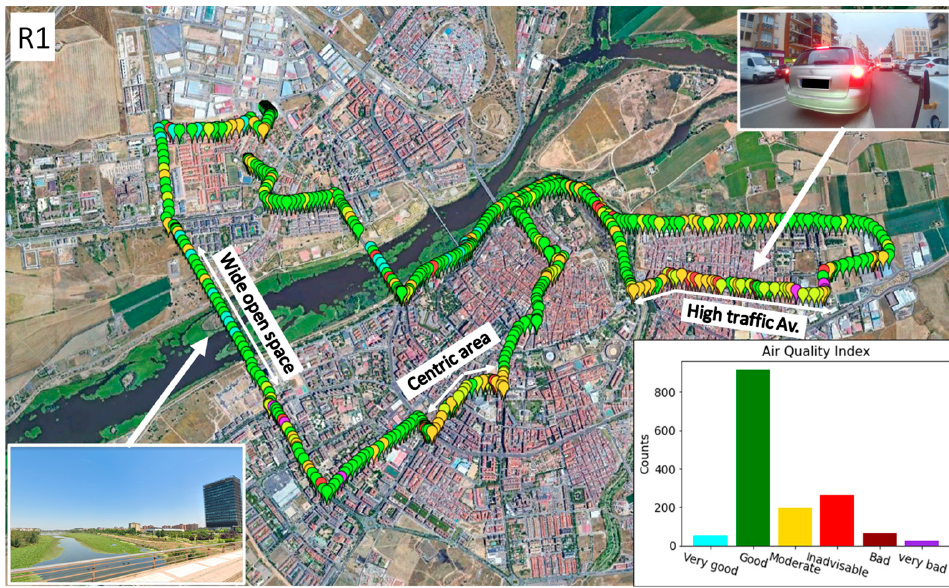
Figure 11. Route 1, Badajoz (Spain), on 22 January 2021. Most relevant zones in terms of air-quality index are shown, and bar chart representing frequency of appearance of each air-quality level.